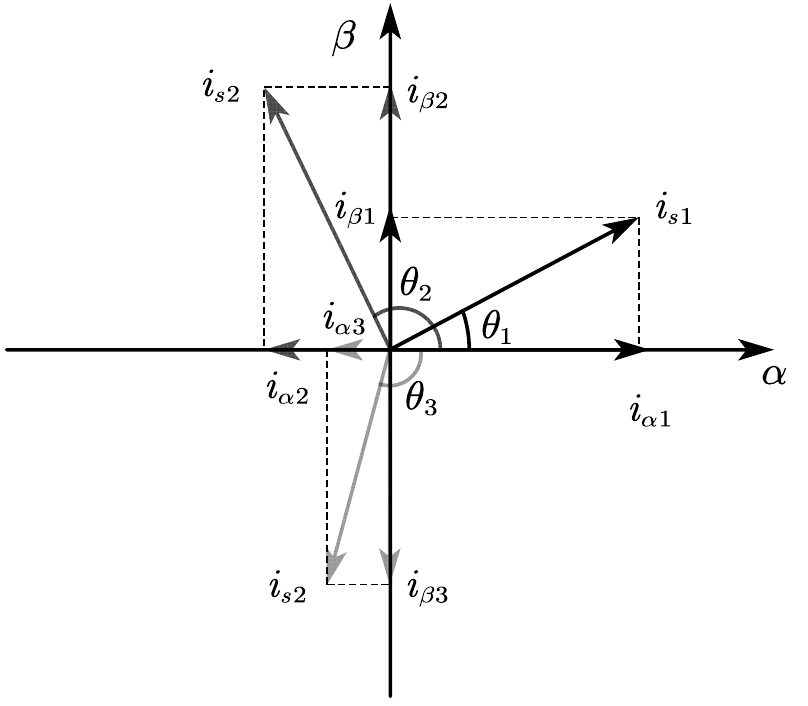
Figure 9. Space position of different current vectors.